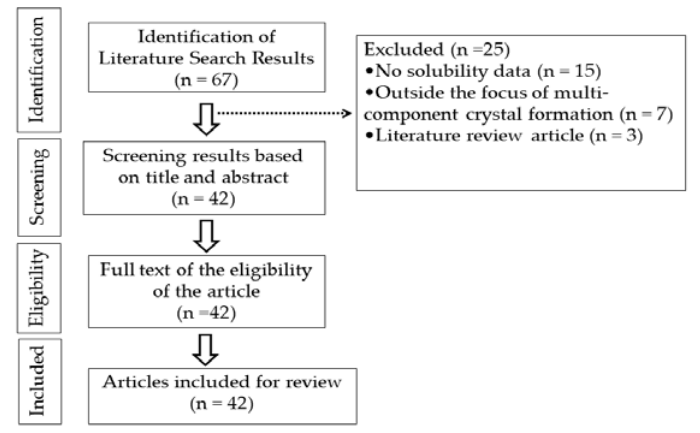
Figure 4. Data extraction.